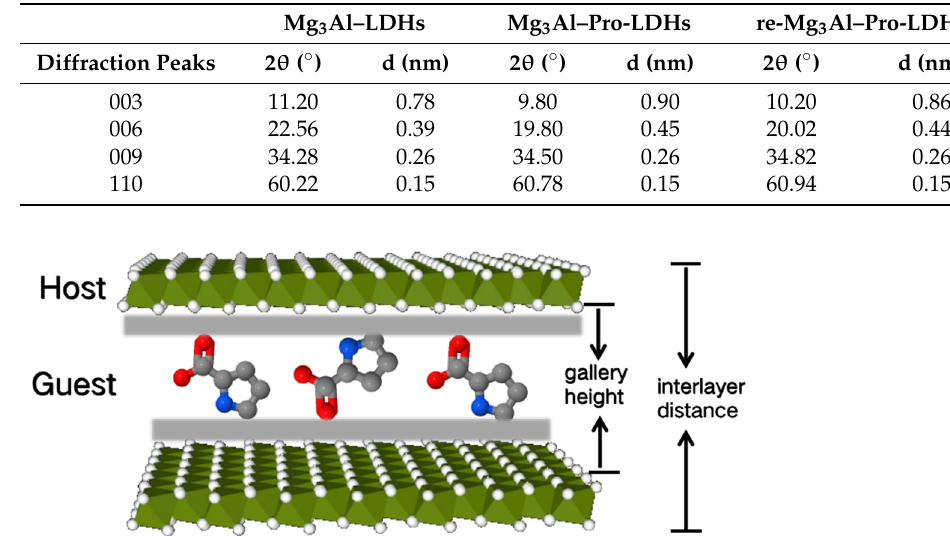
Table 2. XRD data of the diffraction peaks of Mg 3 Al–LDHs, Mg 3 Al–Pro-LDHs, and re-Mg 3 Al–Pro- LDHs.